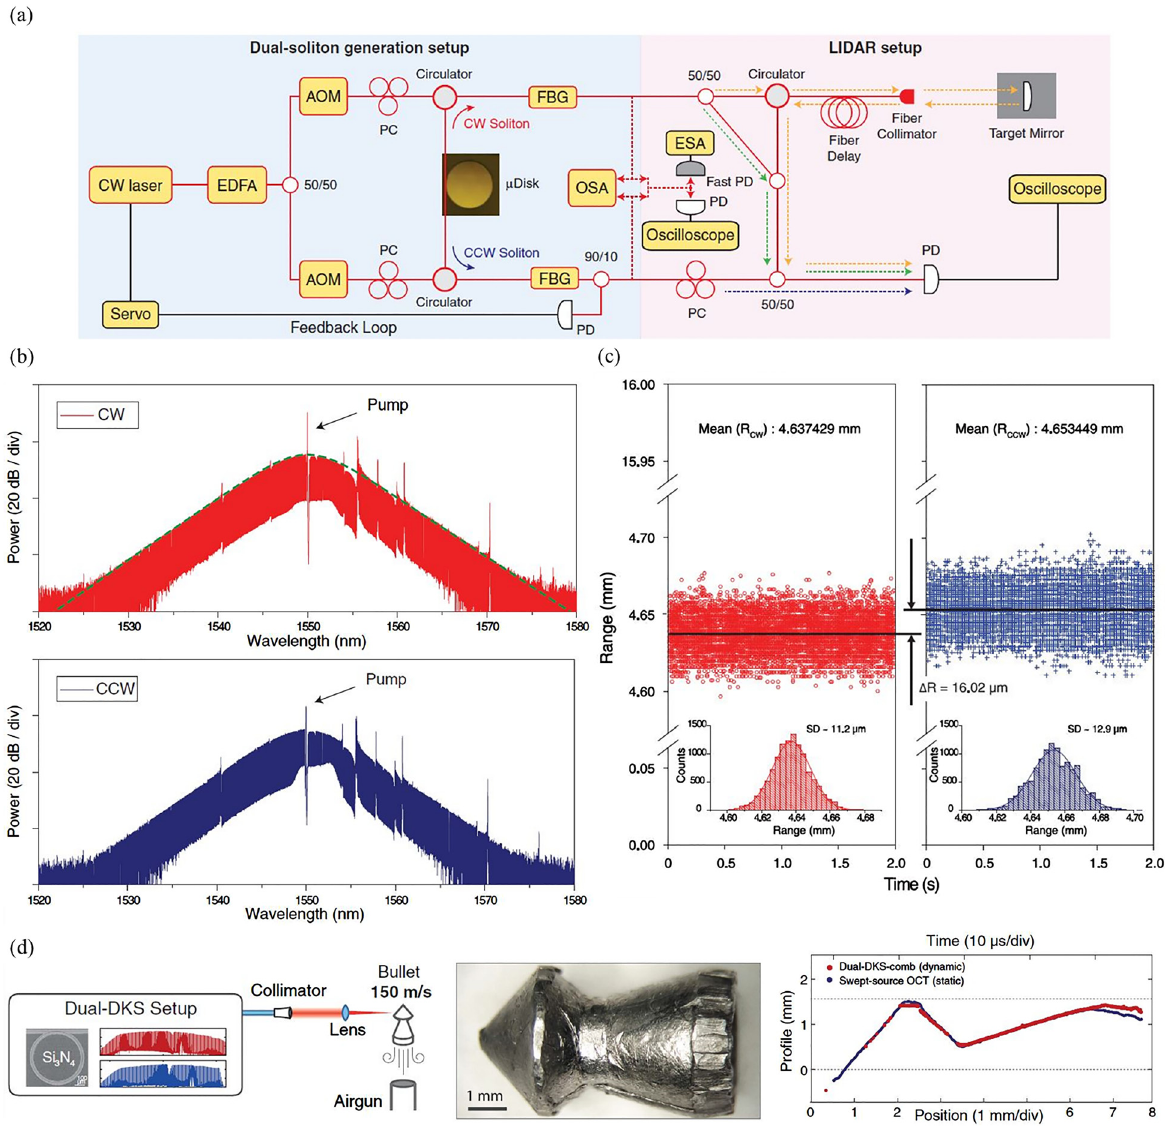
Figure 14: Dual comb-based LIDAR sensing: measurement setup and results. (a)Experimentalsetupfordual-combgenerationandLIDARmeasurement.Apumplasersourceisamplifiedbyanerbium-dopedfiberamplifier (EDFA), followed by a 50/50 splitter to couple into two arms to pump the microdisk resonator in clockwise (CW) and counter clockwise (CCW)directions.Acoustic-opticmodulator(AOM)andpolarizationcontroller(PC)areusedineacharmtotunethepumpforsolitongeneration and ensure ef fi cient coupling into the microdisk resonator, respectively. Fiber Bragg grating (FBG) is used to attenuate the residual pump. Optical signal in spectrum and time domain is monitored by optical spectrum analyzer (OSA) and oscilloscope, respectively. Electric signal is monitoredinspectrumdomainbyelectricsignalanalyzer(ESA).Aservofeedbackloopisusedtolockthepumptothemicrodiskresonatorand hence to stabilize the comb. The CW soliton signal is split into two by 50/50 splitter for distance measurement, as indicated in orange and green colored dashed arrow. These two signals will be combined with CCW soliton signal (blue dashed arrow) to generate interferogram. (b) Optical spectral of CW and CCW soliton. (c) Range data with respect to time using CW and CCW soliton to probe the target. Difference of 16.02 μ m gives the absolute range. Histogram of the range measurement are plotted with Gaussian fi tting, and the standard deviations (SD) are calculated. (a) – (c) are adapted from the study by Suh and Vahala [78]. Reprinted with permission from AAAS. (d) Left: schematic setup of dual-comb-based ultrafast LIDAR measurement. DKS-dissipative Kerr soliton. Middle: Optical image of the static bullet. Right: measured bullet pro fi le using dual-DKS-comb in dynamic status, and benchmarked with the pro fi le measured using swept-source optical coherence tomography (OCT) in static status. (d) is adapted from the study by Trocha et al. [34]. Reprinted with permission from